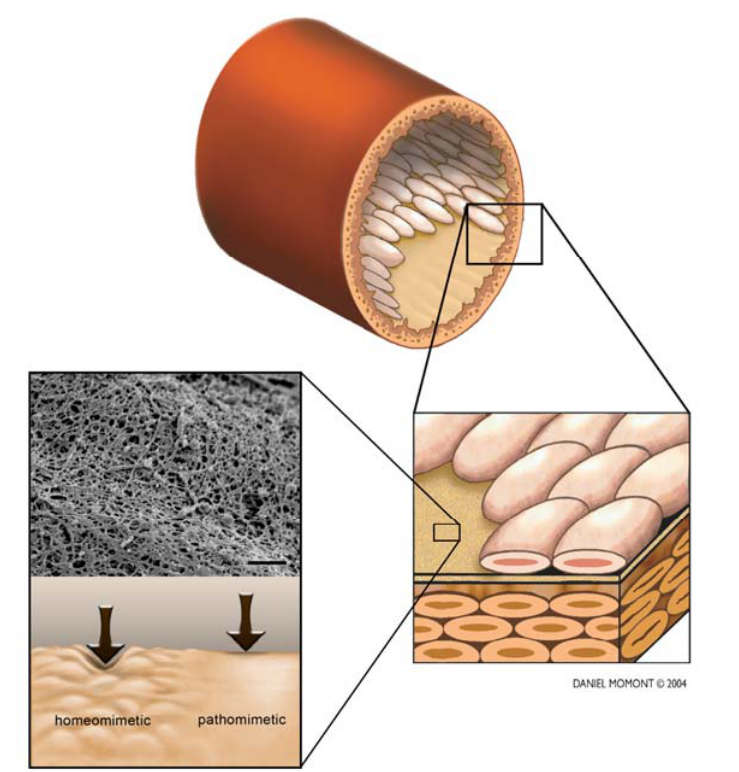
Figure 1. Basement membrane topography and